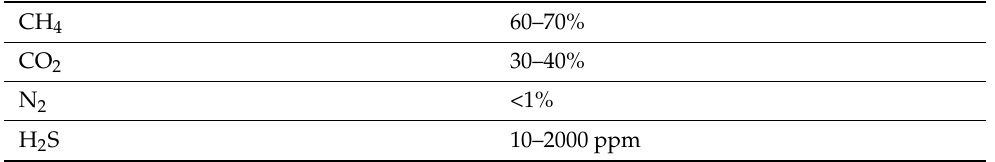
Table 1. Biogas composition